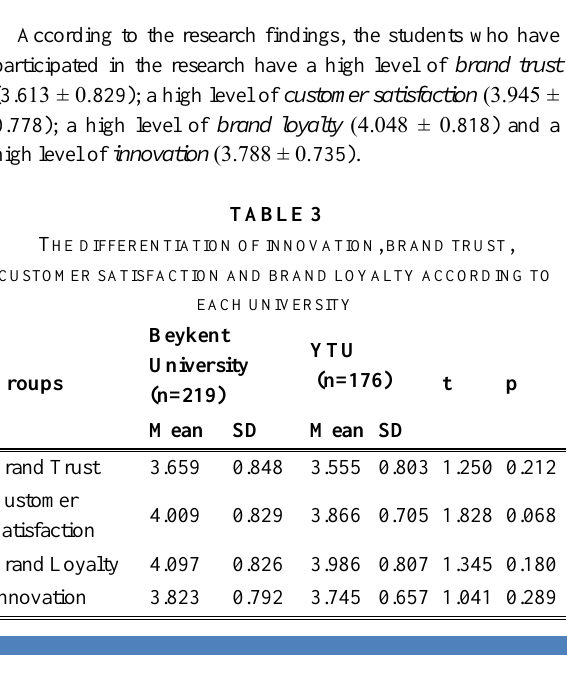
Figure 2. The Innovation, Brand Trust, Customer Satisfaction and Brand Loyalty Levels of the